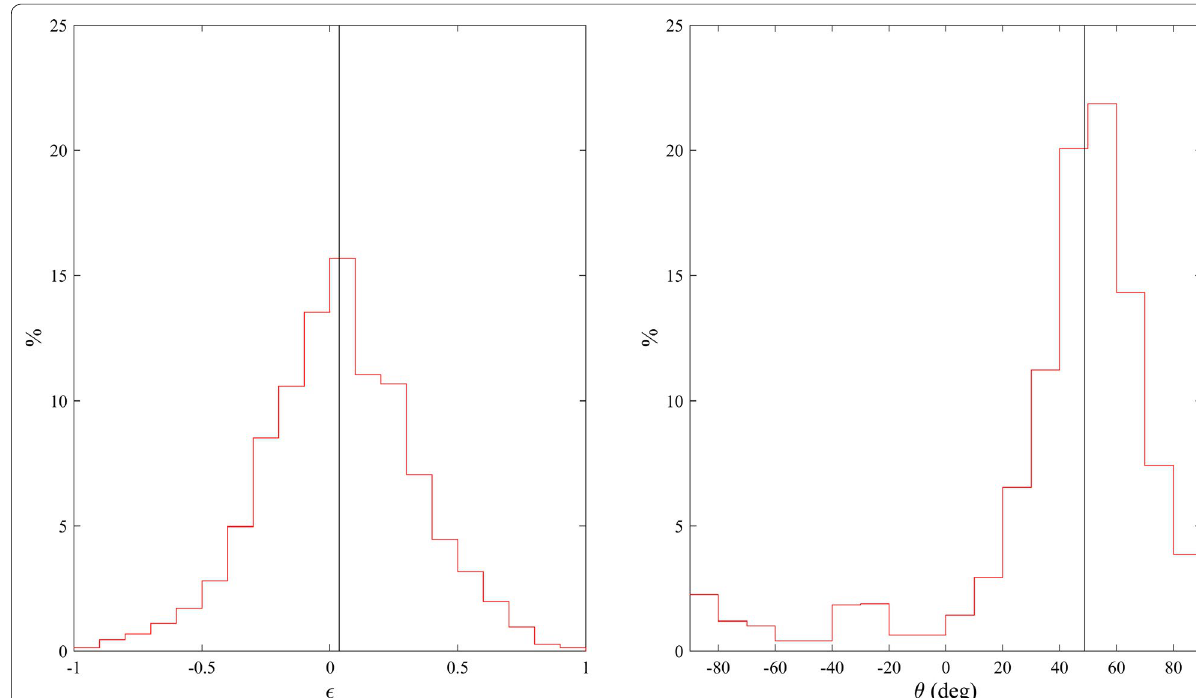
Fig. 8 Polarization parameters. The distribution of ellipticity (left panel) and azimuthal angle (right panel) for polarized events. The vertical black lines mark the median values